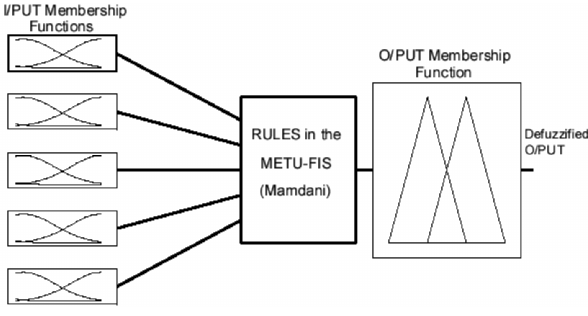
Fig. 1. METU Fuzzy Neural Network Model (METU-FNN-M) block diagram having the METU Fuzzy Inference System (METU- FIS) and the METU-FNN blocks.